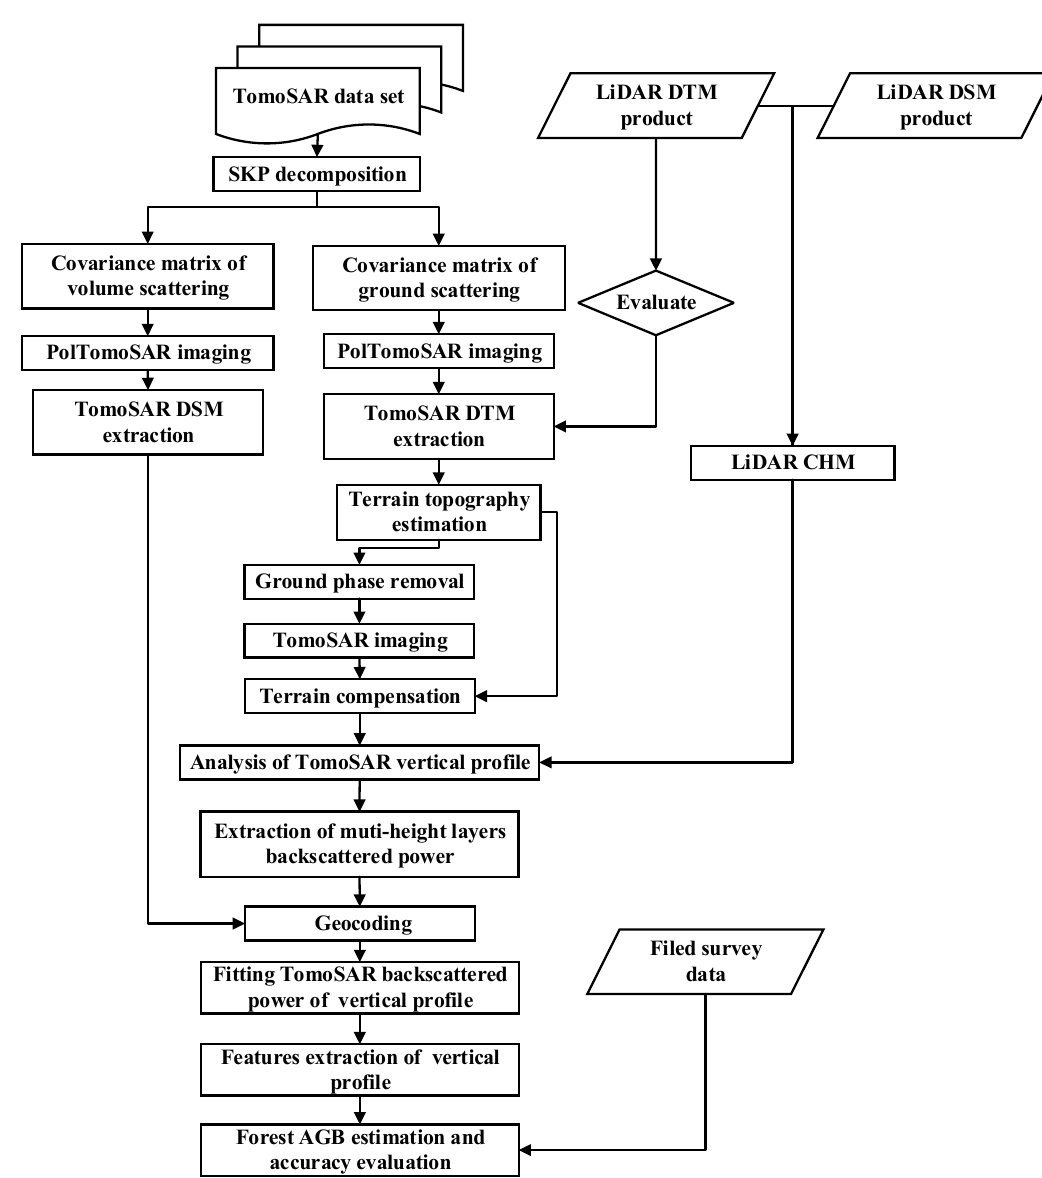
Figure 4. The framework of this study.